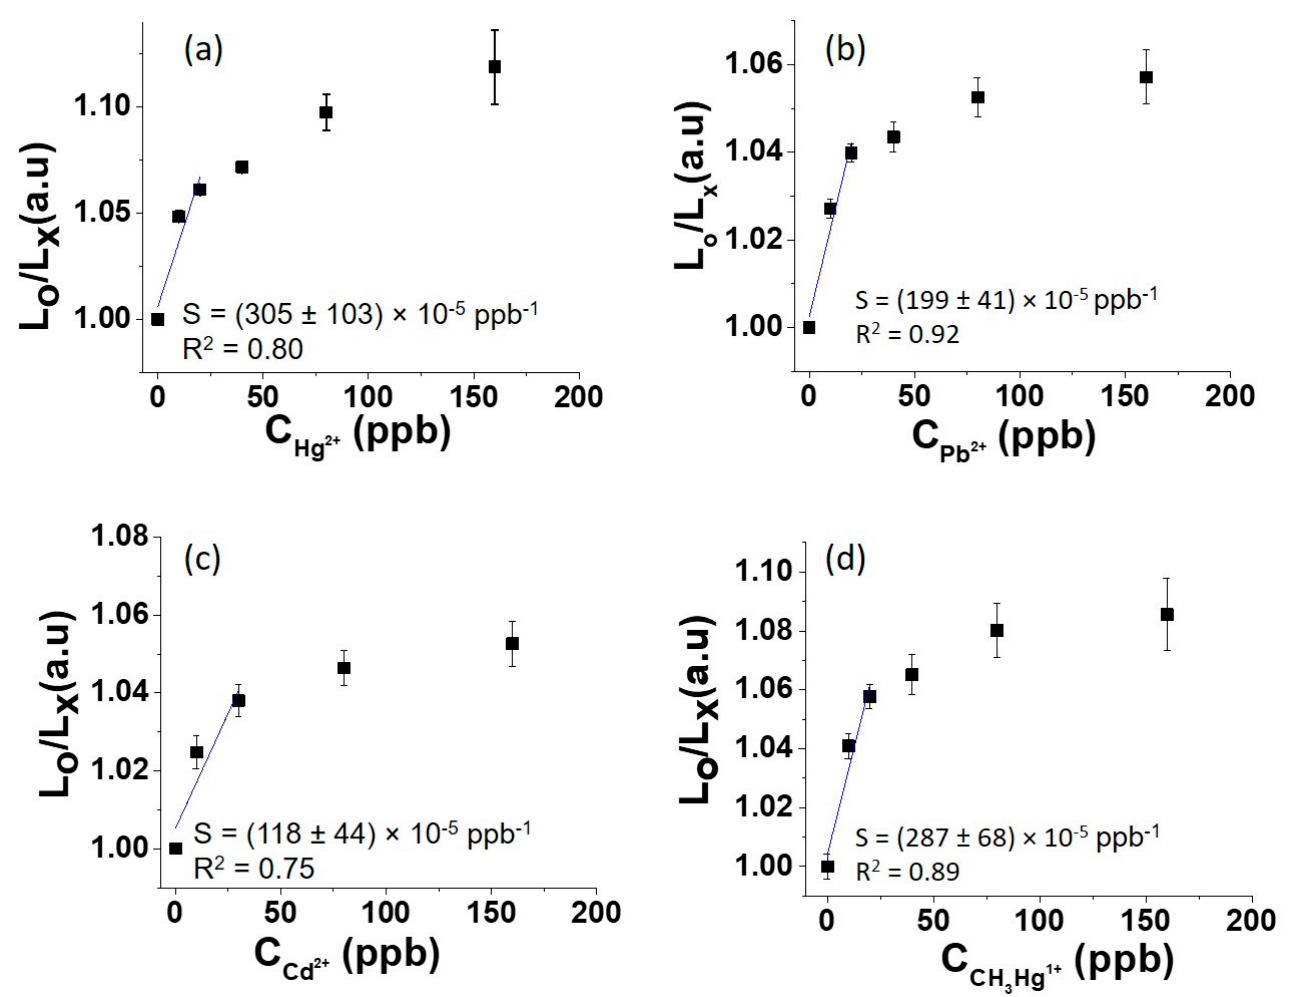
Figure 6. Behavior of L o / L x depending on the concentration of the analytes, for the emission in the blue region at 415 nm, excited at 315 nm. ( a ) Hg 2+ ; ( b ) Pb 2+ ; ( c ) Cd 2+ ; ( d ) CH 3 Hg + . The lines are the linear fits, used for the determination of the linear range and sensitivity (S) of the responses. The error bars were established as authentic replicates of the measurements made on different days on different samples.